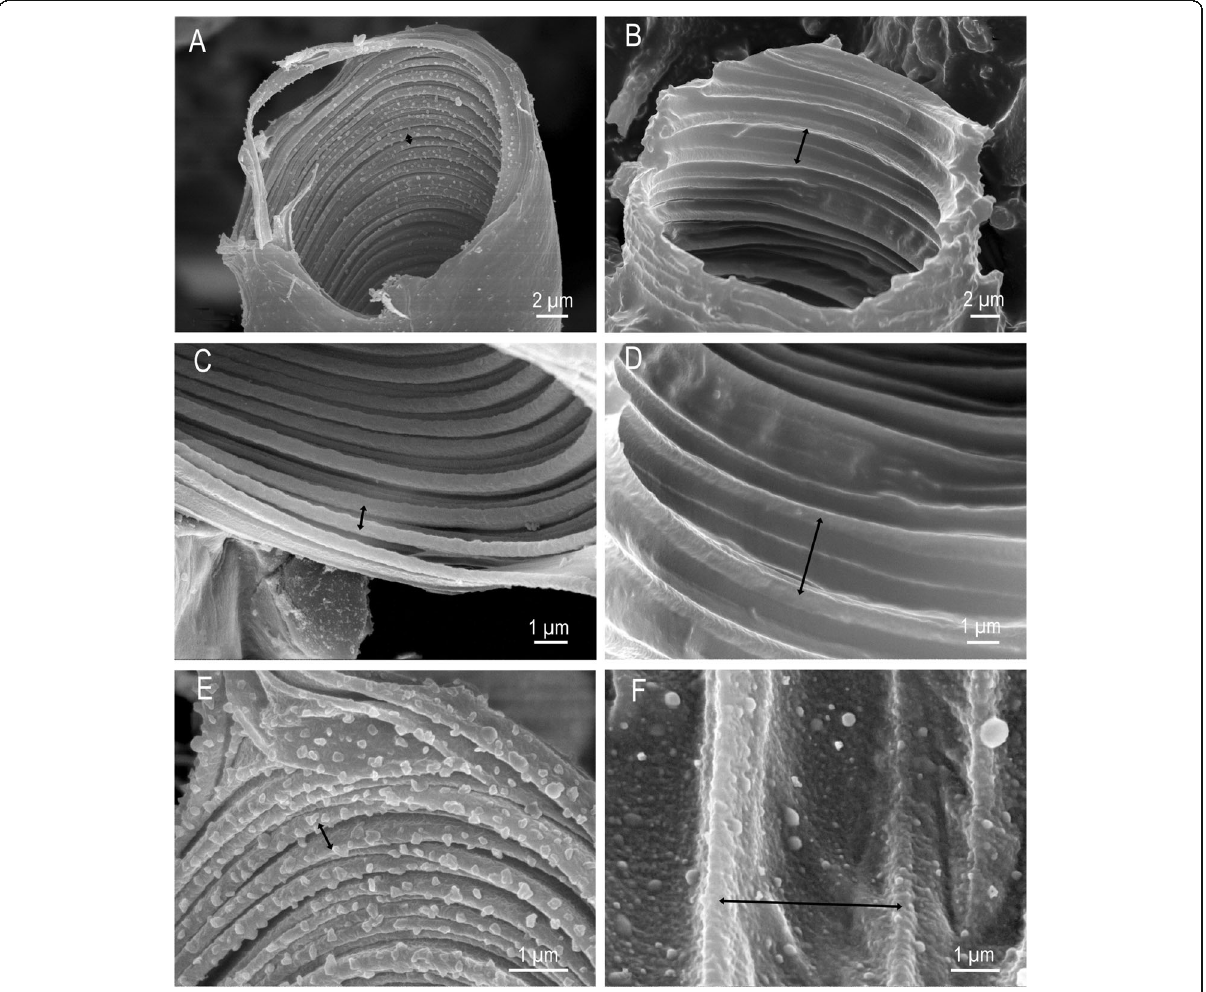
Fig. 8 Ixodes ricinus, scanning electron micrographs of convective tracheae from fasting (left image column, figures a , c , e ) and fully engorged (right image column, figures b , d , f ) females. a Low power micrograph of a trachea of a fasting tick. The distance between the taenidiae is minimal. b Low power micrograph of a trachea of a fully engorged tick. Same magnification as in ( a ). The distance between the taenidiae has greatly extended (black arrow). c Trachea of a fasting tick at intermediate magnification. d Trachea of a fully engorged tick at intermediate magnification. The distance between taenidia has more than tripled, indicating the expansion of the tracheae associated with the volume increase of the body. e High power magnification of a trachea of a fasting tick. In this position the internal surface of the tracheae is densely covered with microstructures. f High power magnification of a trachea of a fully engorged tick. Same magnification as in ( e ). Double headed arrows indicate distance between two neighboring taenidia in fasting (left) and digesting (right)